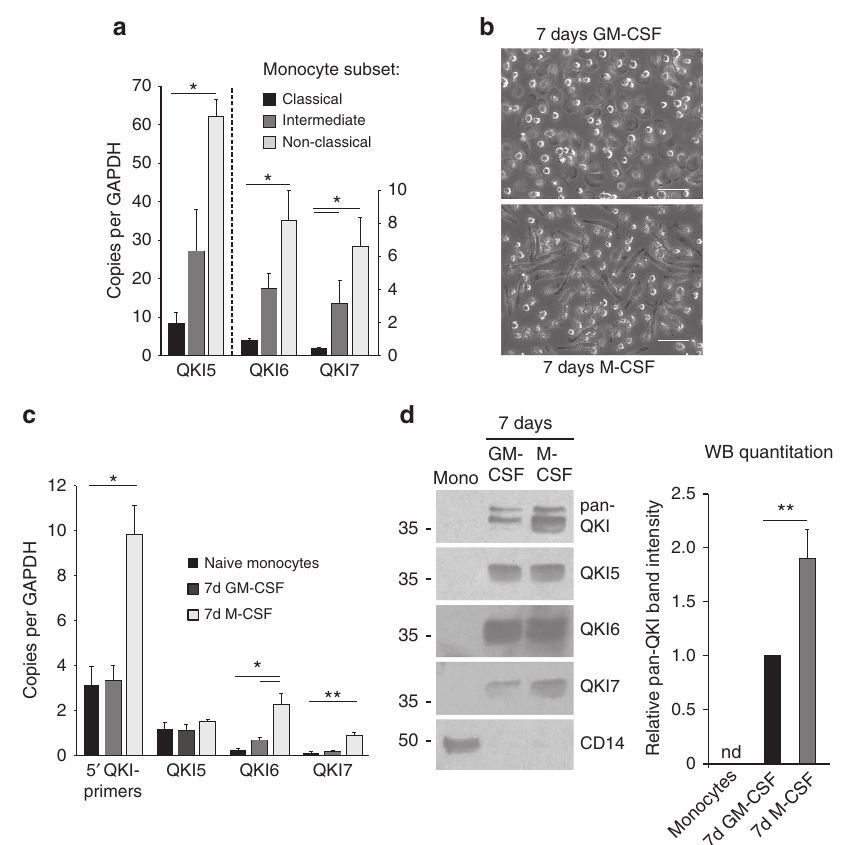
Figure 2 | QKI is highly expressed in macrophages derived from PB monocytes. ( a ) mRNA expression levels of distinct QKI isoforms following negative selection and FACS sorting for blood-derived human monocyte subsets, namely classical (CD14 þ þ , CD16 (cid:2) ), intermediate (CD14 þ þ ,CD16 þ ) and non-classical (CD14 þ ,CD16 þ ). Expression is depicted relative to copies per glyceraldehyde 3-phosphate dehydrogenase (GAPDH). Data expressed as mean ± s.e.m.; one-way analysis of variance (ANOVA), Bonferroni’s post-hoc test; * P o 0.05 and ** P o 0.01. ( b ) Phase-contrast photomicrographs of human PB monocytes cultured for 7 days in the presence of either GM-CSF or M-CSF. Scale bar, 50 m m. ( c ) Quantitative RT–PCR (qRT–PCR) analysis for QKI mRNA isoforms in naive PB monocytes isolated using CD14 þ microbeads, 7 days GM-CSF and 7 days M-CSF differentiated macrophages ( n ¼ 3). Expression is depicted relative to copies per GAPDH. Data expressed as mean ± s.e.m.; one-way ANOVA, Bonferroni’s post-hoc test; * P o 0.05 and ** P o 0.01. ( d ) Western blot analysis of QKI protein isoforms in naive monocytes, 7 days GM-CSF and 7 days M-CSF differentiated macrophages (pan-QKI and CD14: n ¼ 5, QKI-5, 6 and 7: n ¼ 1) with quantification of pan-QKI ( n ¼ 5). Data expressed as mean ± s.e.m.; Student’s t -test, with ** P o 0.01. Equivalent concentrations of whole-cell lysates were loaded per lane as determined using a BCA protein